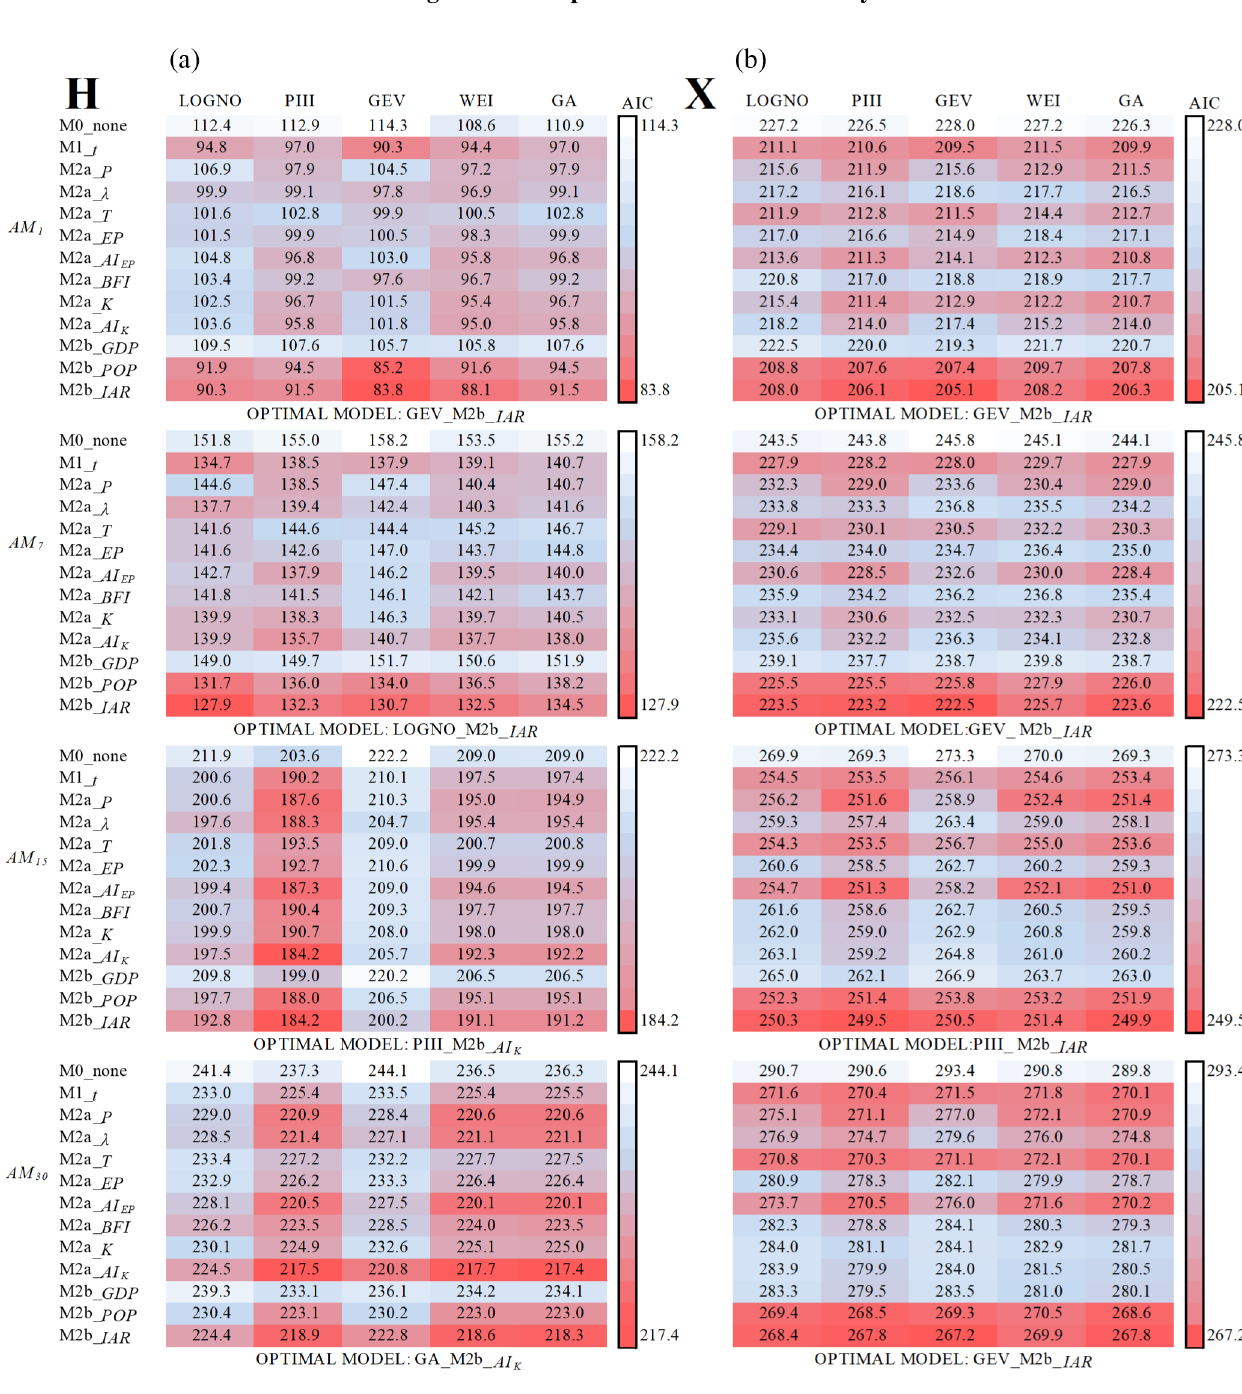
Figure 7. Comparisons among M0, M1 and M2 based on the AIC values for the four observed low-flow series in Huaxian (H) at (a) and Xianyang (X) at (b) ; darker red color represents a higher goodness of